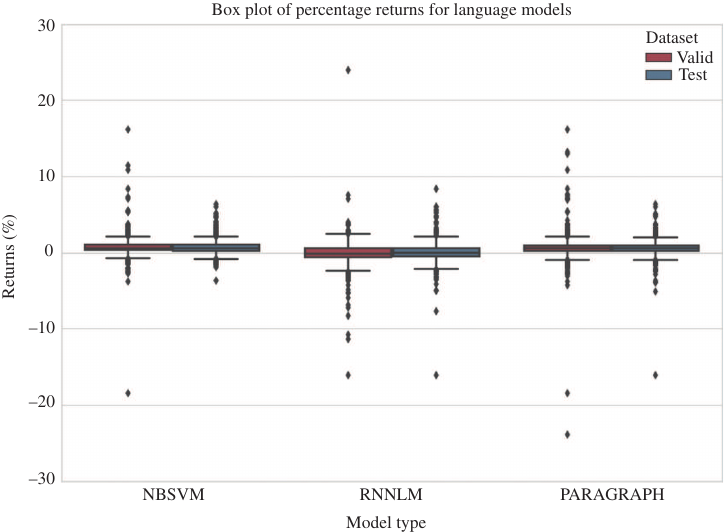
Figure 7: Percentage Returns Compared Using a 60-Min Exit Strategy on Language